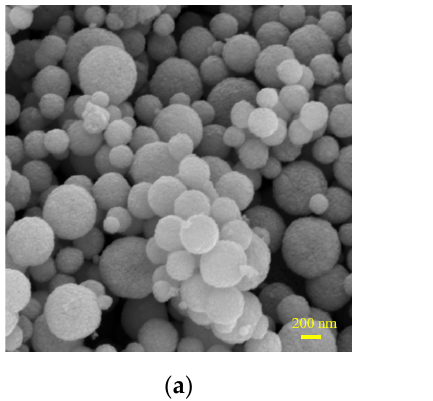
Figure 1. Ultraviolet absorption spectra of E2, MAA, and mixture of E2 and MAA in acetonitrile solution.